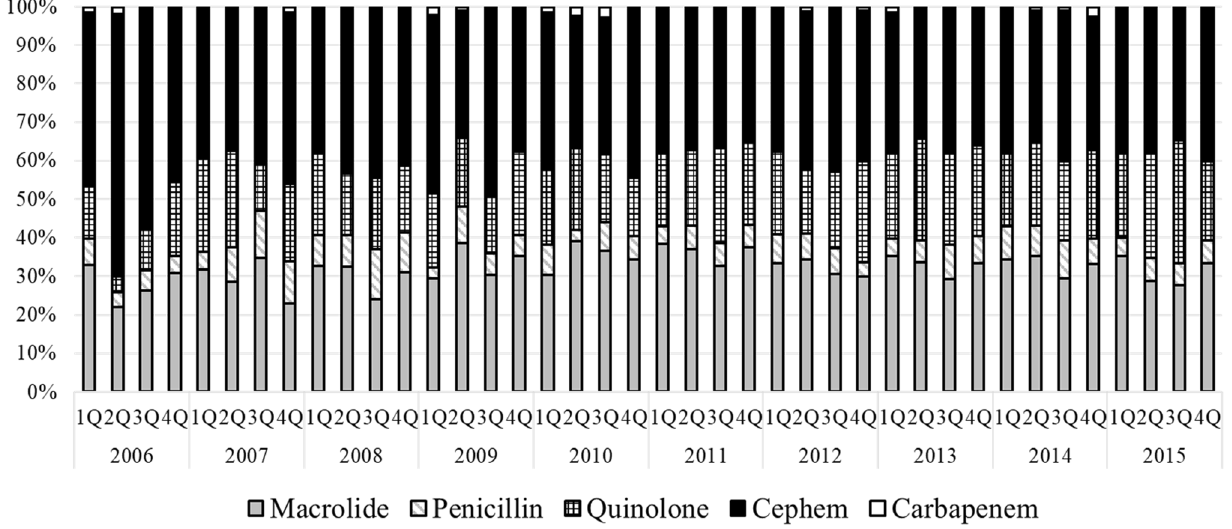
Figure 1. Trend for antibiotics class from 2006 to 2015 in patients with common cold.